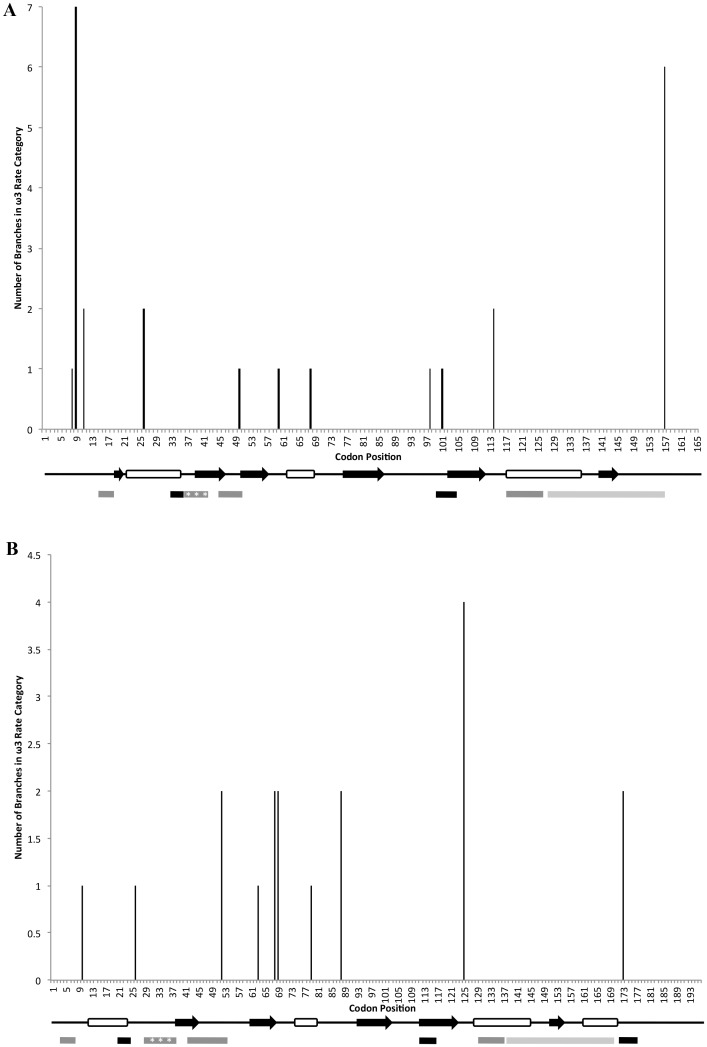
The number of branches with the highest probability of being in the ω3 rate category plotted across each codon position for the (A) plant ADF and (B) animal CFL/ADF protein variants.A linear representation of the secondary structure is depicted directly below each graph, where open cylinders represent α-helices and black arrows represent β-sheets. Conserved binding regions are depicted below the secondary structures, with black bars represent F-actin binding regions, dark gray bars represent regions that are involved in both G-actin and F-actin binding, light gray bars are regions involved in only G-actin binding, and the dark gray bar with asterisks is the nuclear localization sequence. Tertiary structure and binding domains are based on [33] and [34]. The numbering of codon positions is based on protein sequence alignments used for phylogenetic analyses and selection analyses.